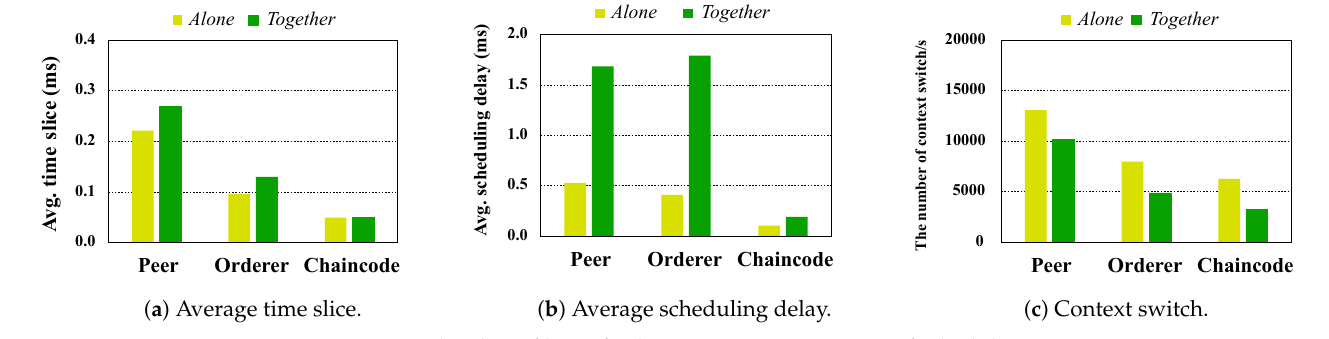
Figure 4. System-level profiling of Fabric components in terms of scheduling metrics. Table 3. System-level profiling of sysbench